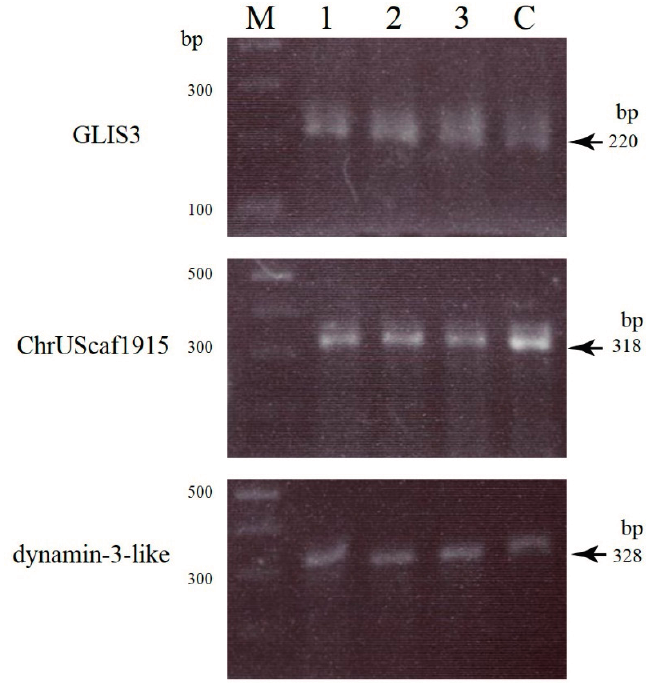
Figure 5. T7E1 analyses of three potential off-target sites (zinc finger protein GLIS3 , ChrUScaf1915 , and dynamin-3-like ) in blastocysts no. 1 (lane 1 ), 2 (lane 2 ), and 10 (lane 3 ) together with normal PEFs (lane C ). Two bands (~140 and ~80 bp) are expected to be cleaved from the 220 bp PCR products of GLIS3 . Two bands of ~200 and 120 bp are expected to be cleaved from the 318 bp PCR products of ChrUScaf1915 . Two bands of ~200 and ~130 bp bands are expected to be cleaved from the 328 bp PCR products of dynamic-3-like . However, there is no appreciable off-target cleavage in the samples tested. M , 100 bp ladder